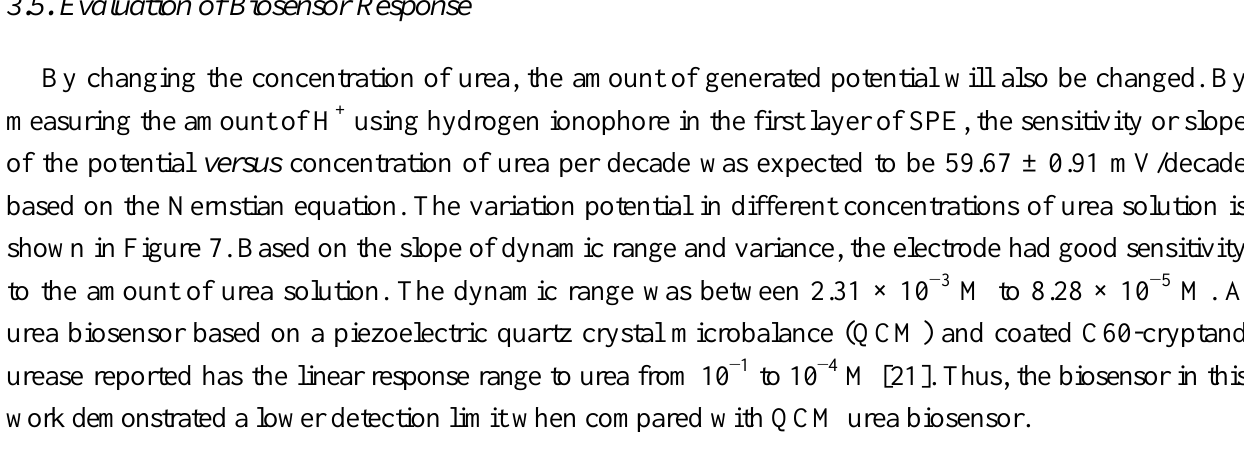
Figure 7. Variation in potential versus concentration of urea in 5 × 10 −4 M PBS (pH